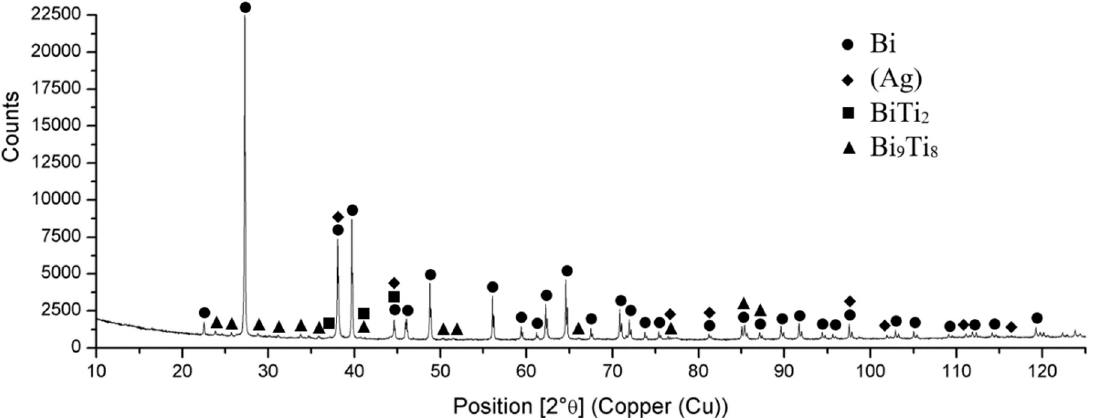
Figure 9. XRD analysis of Bi11Ag1.5Ti solder.